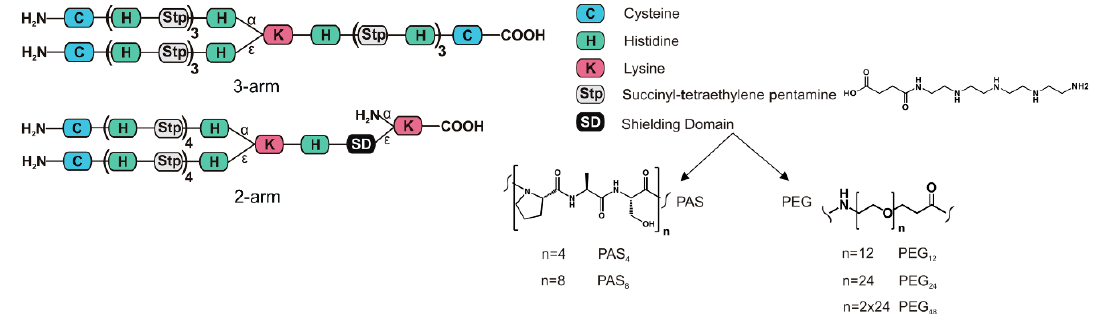
Scheme 1. Schematic structures of the oligomer topologies evaluated in this paper. PAS: proline- alanine-serine; PEG: polyethylene glycol.